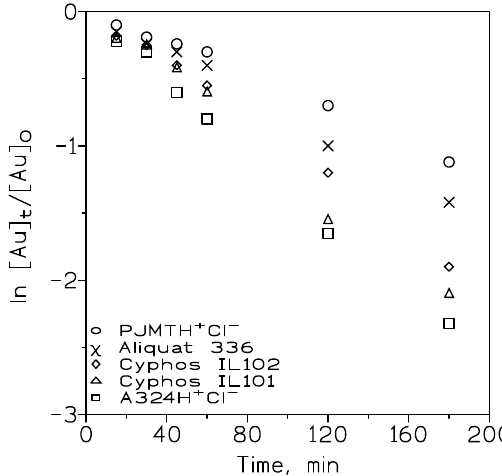
Figure 5. Permeability behavior of gold(III) using various ionic liquids as carriers.